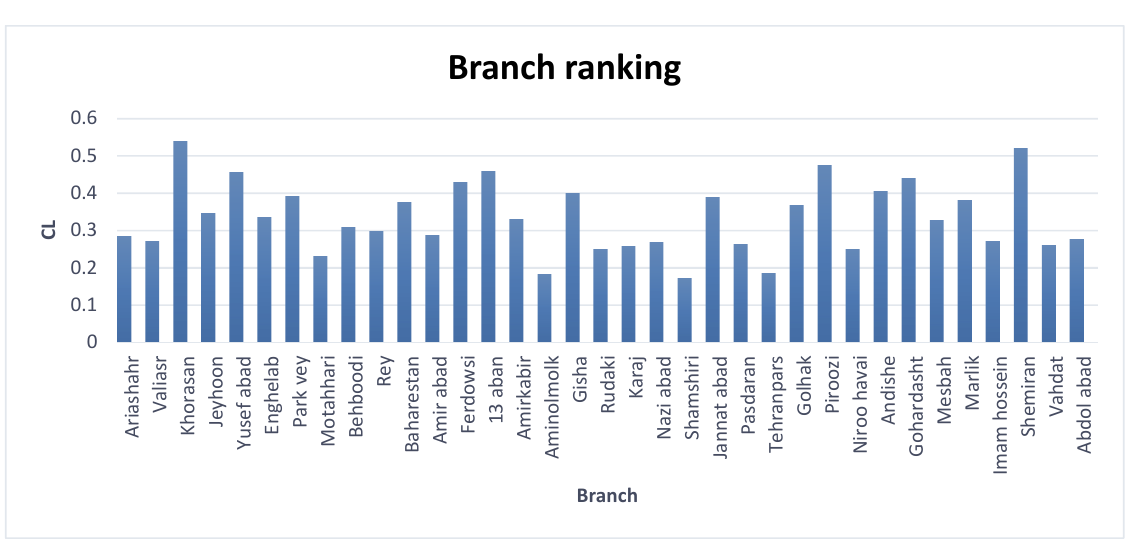
Fig. 4. Branch ranking using